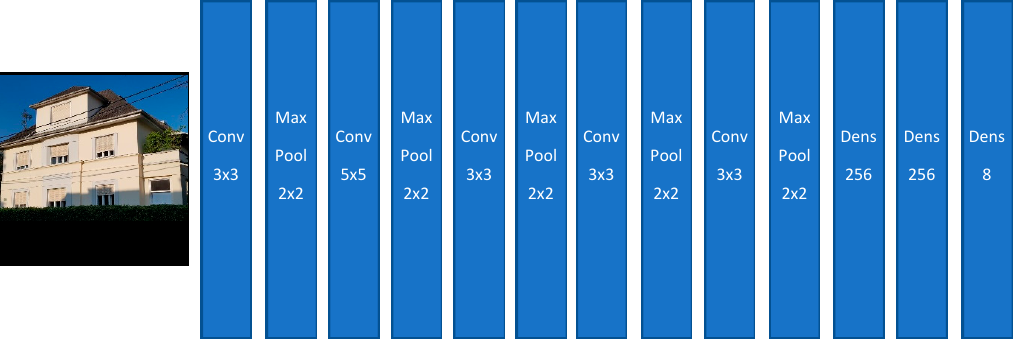
Figure 13. House classification Model I (Source of input image: our own image).